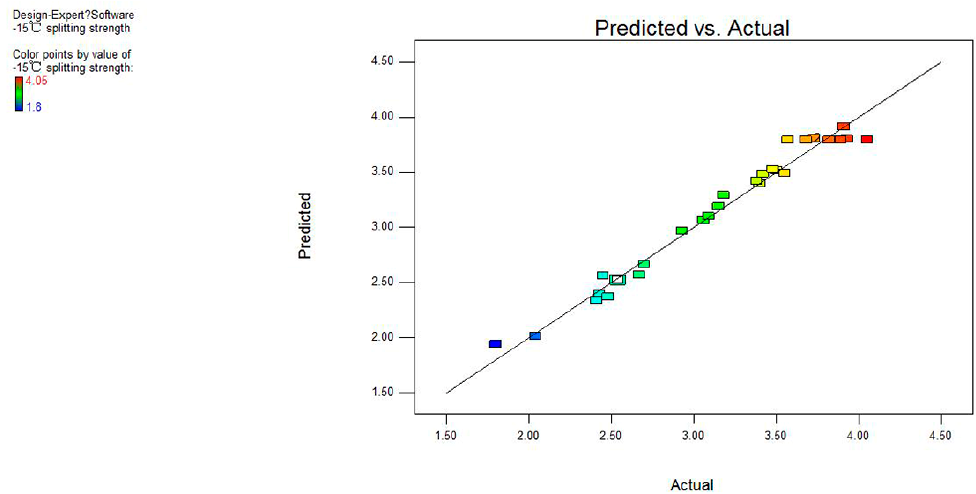
Figure 5. Predicted against actual responses of − 15 °C spli tt ing strength.